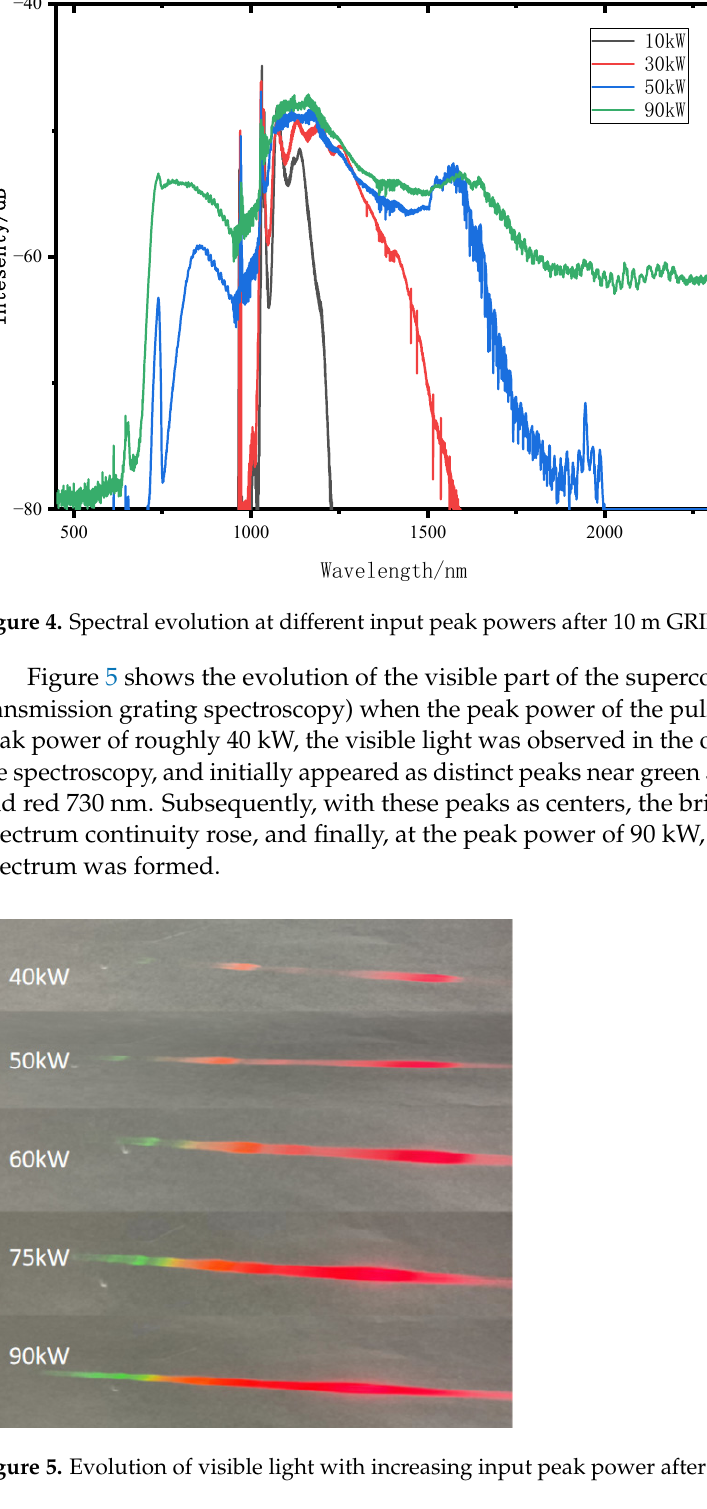
Figure 6. Spectral evolution after different GRIN fiber length at 30 W input power. The output power of the supercontinuum decreased with the increasing length of GRIN fiber. The maximum output supercontinuum average power was about 24.9 W, 22.3 W, and 15.2 W at the fiber length of 5 m, 10 m, and 80 m, respectively. This was mainly due to the high absorption loss of graded-index fiber for some wavelengths. While ensur- ing a high-quality supercontinuum output, the GRIN fiber length should be controlled to avoid power degradation. Figure 7 shows the efficiency curves of the pump power and supercontinuum power at the GRIN fiber length of 5 m. The overall conversion efficiency of the supercontinuum was about 82%, which was higher than that with photonic crystal fiber (about 50%), demonstrating the effectiveness of direct splicing of a GRIN fiber with the gain fiber. Continuous operation at the highest power for 4 h is realized, and the power instability is less than 1.8% with the spectrum and beam quality remaining basically un- changed. 500